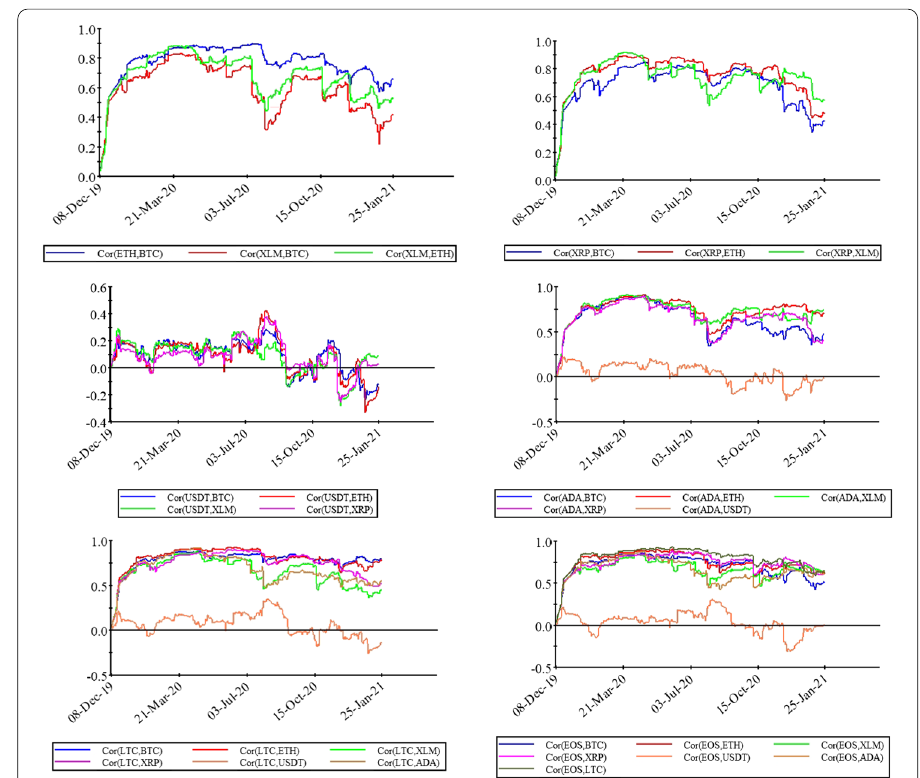
Fig. 4 A plot of conditional correlations of selected